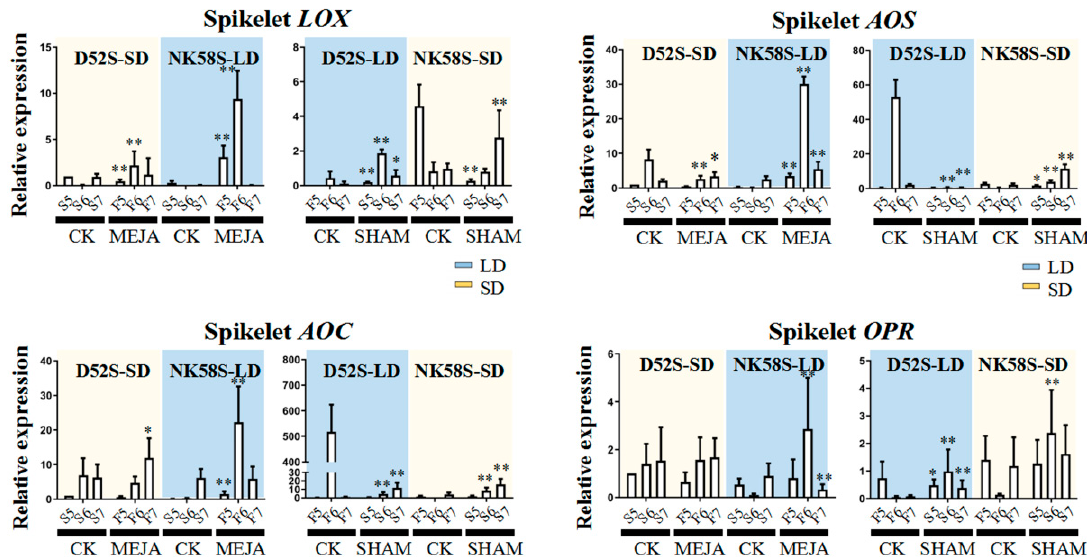
Figure 6. Expressions analysis of JA synthesis enzyme genes in fertility-reverse plants treated by MEJA/SHAM-spraying treatment. The qPCR analysis of LOX , AOS , AOC and OPR in the spikelets from NK58S and D52S sterile/fertile/fertility-reverse lines during 5th–7th-stage. The internal reference gene is OsActin . By photoperiod conditions and spraying treatment, the LD/SD-treated plants are marked with blue/yellow background, respectively. Data are shown as mean ± standard deviation ( n = 3). Asterisks indicate significant differences of gene expression between spraying-induced reversed-fertility plants and those in the control group at the same period revealed by Student’s t -test (*, p < 0.05; **, p < 0.01). LD, long-day cycle; SD, short-day cycle; MEJA, methyl jasmonate; SHAM, salicylhydroxamic acid; CK, control; S/F/R, sterile/fertile/fertility-reverse plants; 5/6/7, 5th/6th/7th-stage.